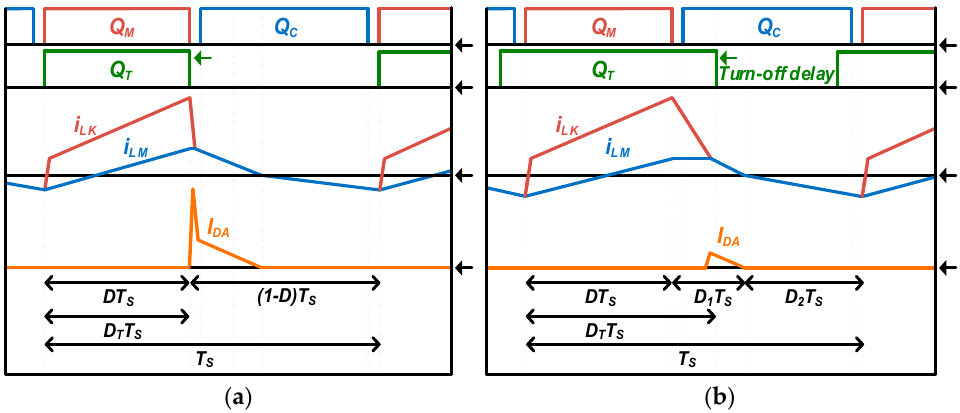
Figure 4. Simplified additional diode current waveform: ( a ) three ‐ switch active ‐ clamp forward converter; ( b ) proposed converter.